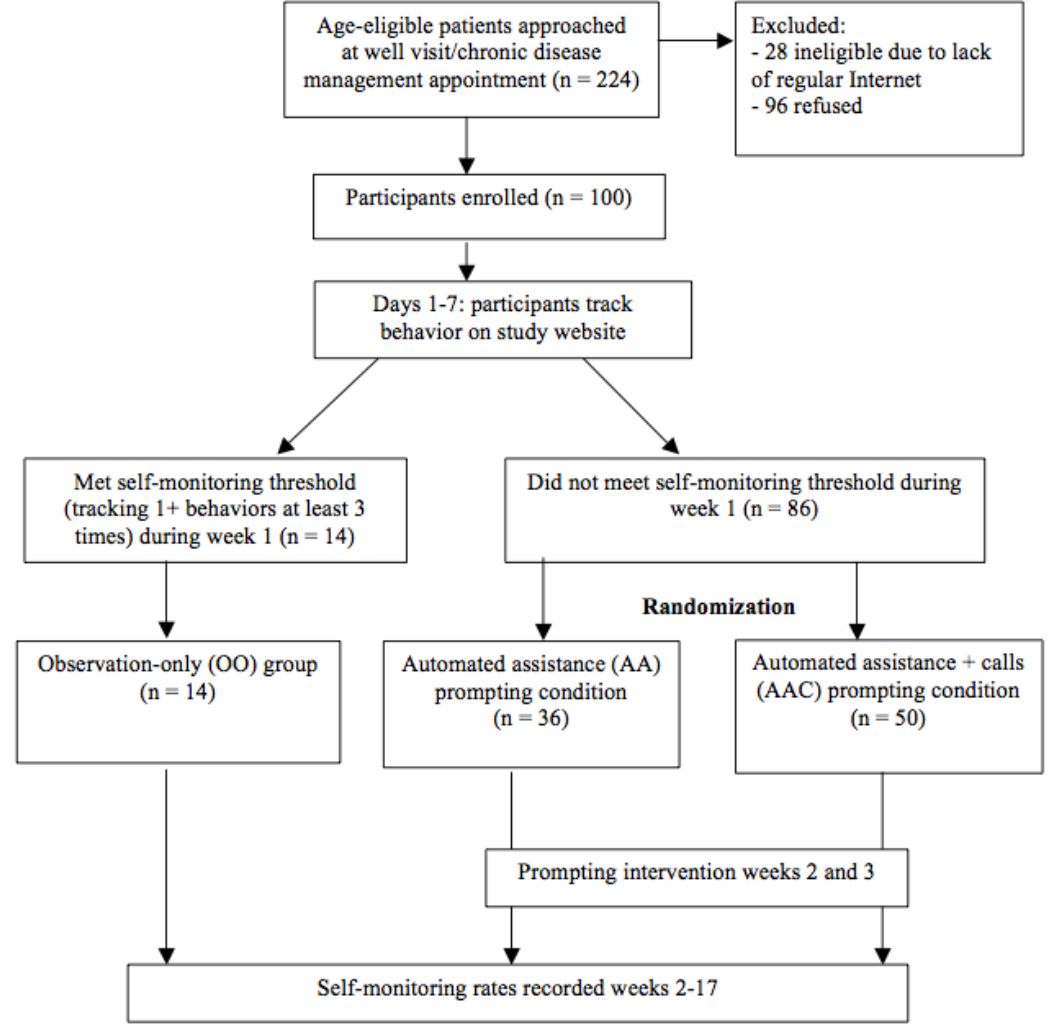
Figure 1. Flow of participants through the